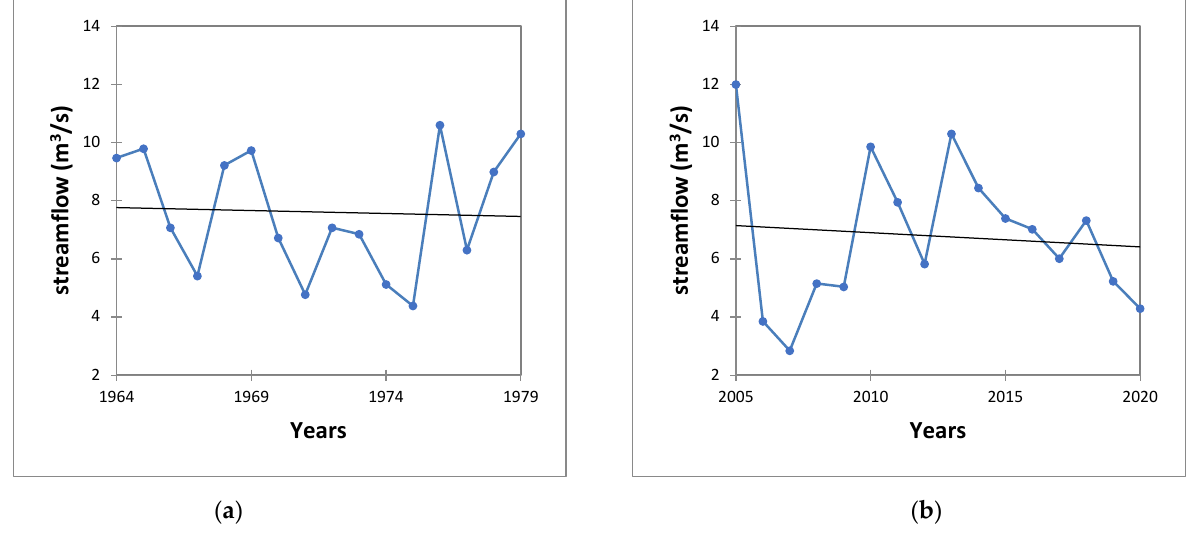
( b ) Figure 9. Potential evapotranspiration and trend line in black colour: ( a ) 1964 – 1979; ( b ) 2005 – 2020 . 3.4. Streamflow Trend and Effective Rainfall Trend From 1964 to 1979 the minimum streamflow recorded at the San Severino Marche hydrometer station in the Potenza River was 3.757 m 3 /s, and the maximum streamflow was 12.166 m 3 /s, while the mean average streamflow of the river was 7.594 m 3 /s (Figure 9). The Mann–Kendall test for annual streamflow shows a decreasing trend, and Sen’s slope test also indicates a decreasing trend in annual streamflow of magnitude − 0.046 m 3 /year (Table 4). The period from 2005 to 2020 shows an average value of 6.730 m 3 /s. As can be seen in Figure 10, there is a non-significant decreasing trend in the current streamflow. The magnitude of Sen’s slope is − 0.082 m 3 /year, which indicates a decreasing trend (Table 4).